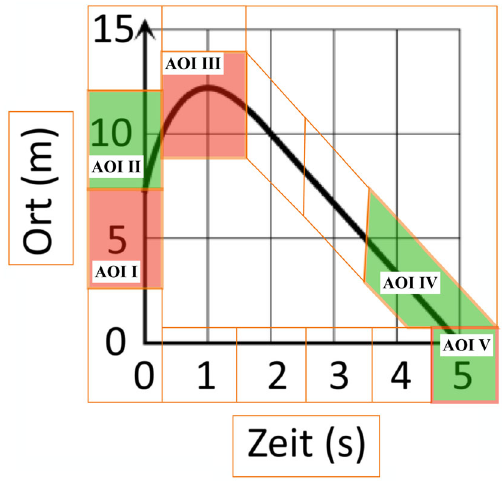
FIG. 4. PredictiveAOIsofitem18(red:longerTVDwithincorrect answer, green: longer TVD with correct answer). The axis labels are written in German and mean time (Zeit) and position